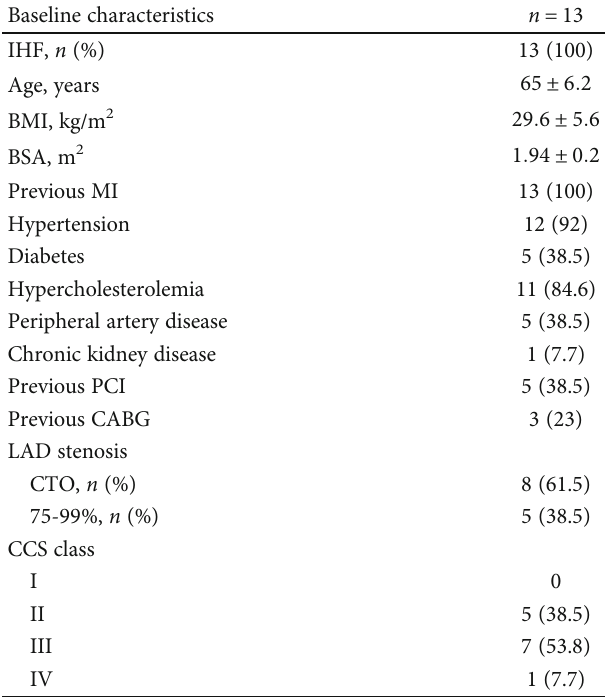
Table 1: Baseline assessment. Baseline